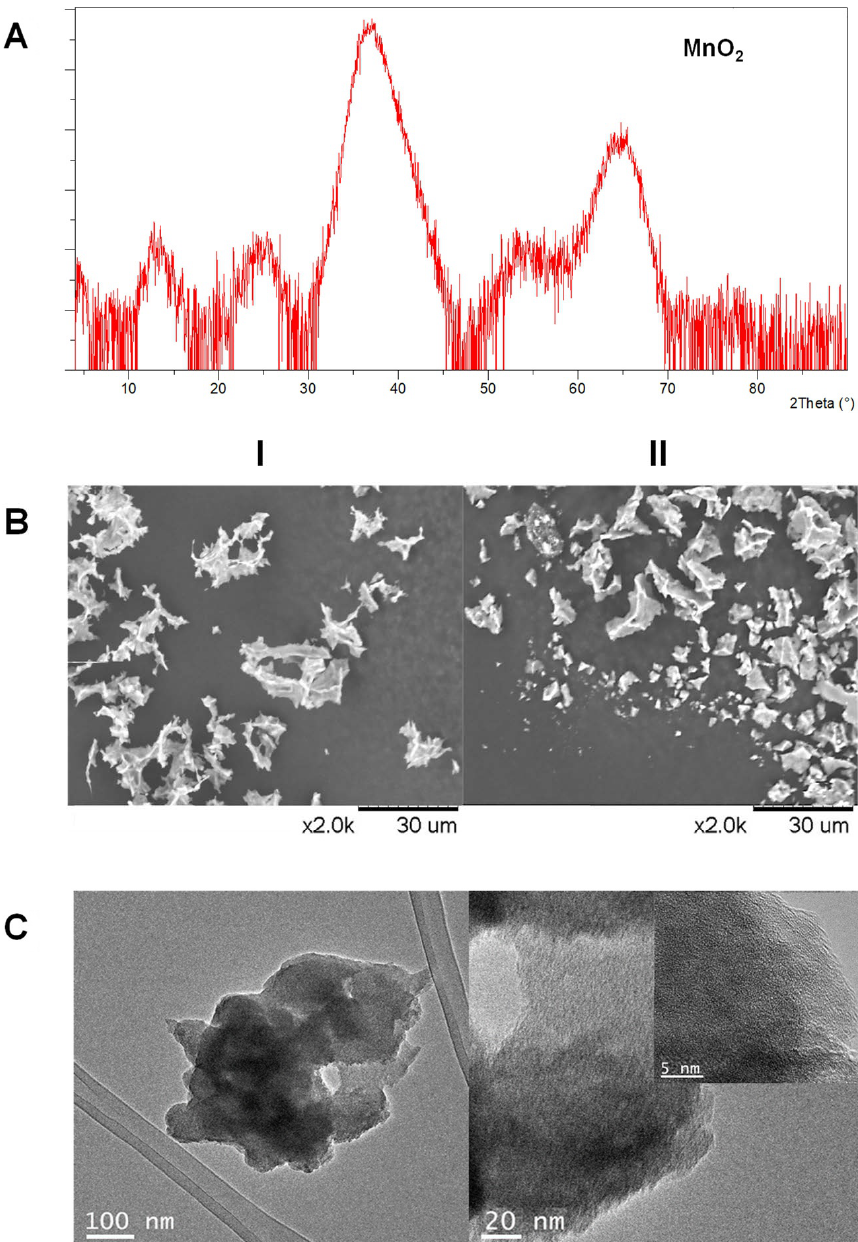
Figure 4. Characterization of MnNPs@CALB-H 2 O and MnNPs@CALB-DMF hybrids: ( A ) XRD spectrum; ( B ) SEM images: (I). MnNPs@CALB-H 2 O and (II). MnNPs@CALB-DMF ; ( C ) TEM images of MnNPs@CALB-DMF .